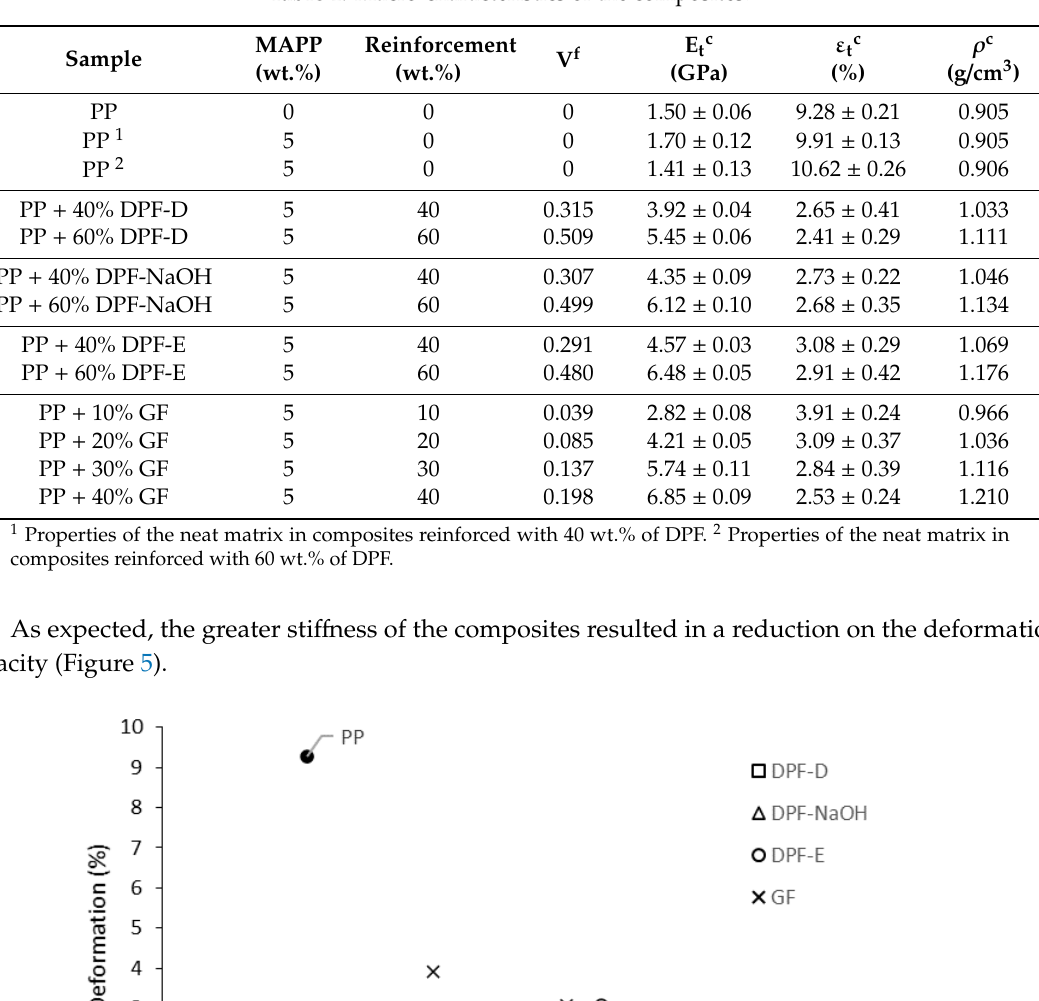
Table 1. Macro-characteristics of the composites.